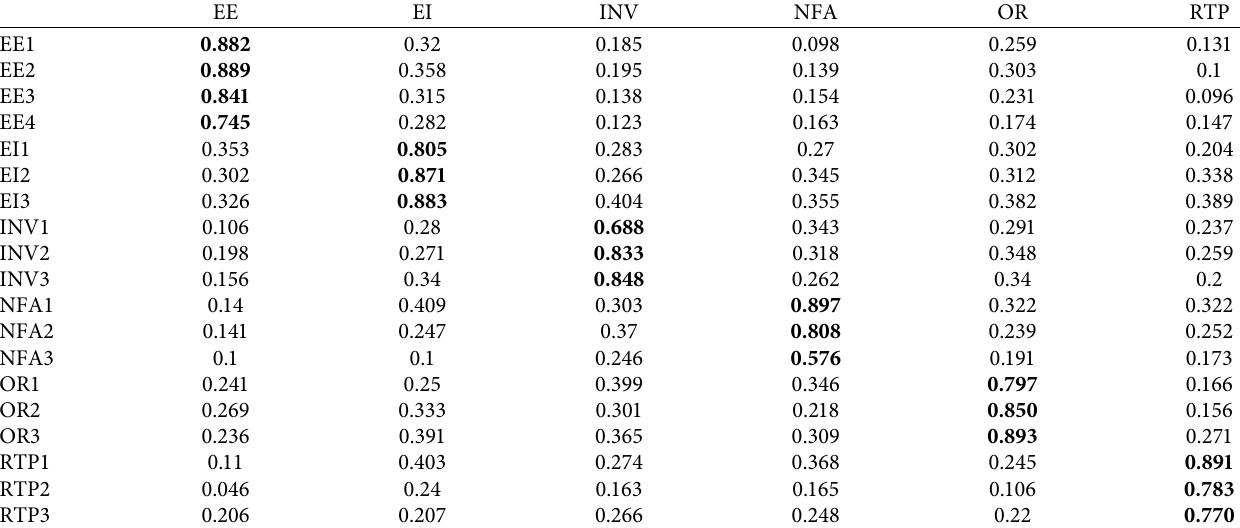
Table 4: Cross loadings.